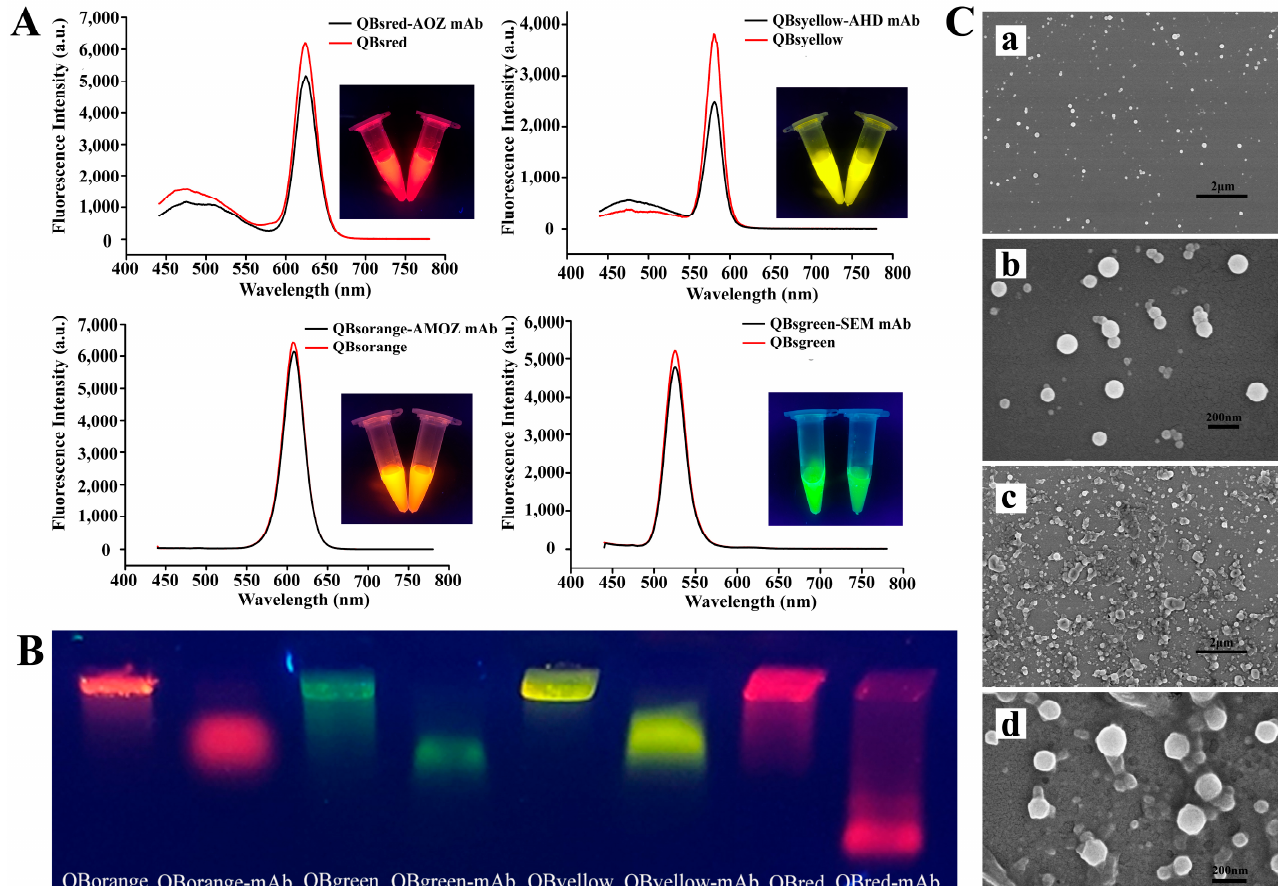
Figure 2. ( A ) Fluorescence emission spectra of QBs and QB-mAb probes. The inset shows the corresponding photograph of QBs and QB-mAb probes solutions under UV light at 365 nm, ( B ) fluorescent images of QBs and QB-mAb in 0.5% agarose gel after gel electrophoresis, ( C ) SEM images of QBs at magnifications of ( a ) 10,000× and ( b ) 60,000×, and QB-mAb probes at magnifications of ( c ) 10,000× and ( d ) 60,000×.